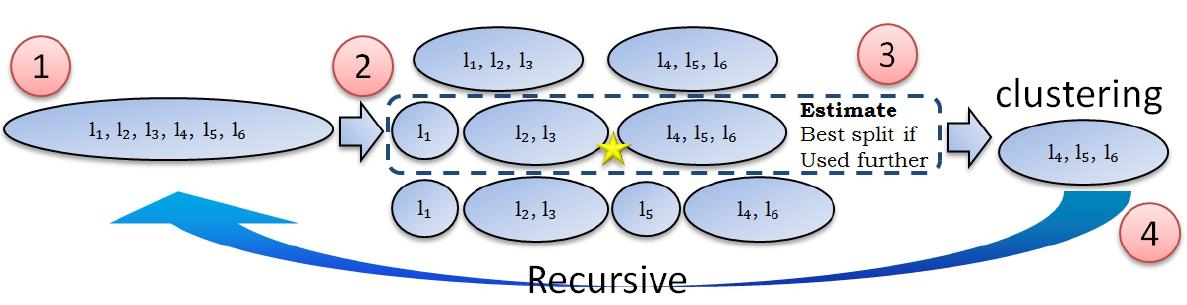
Figure 2. Example: building one layer.